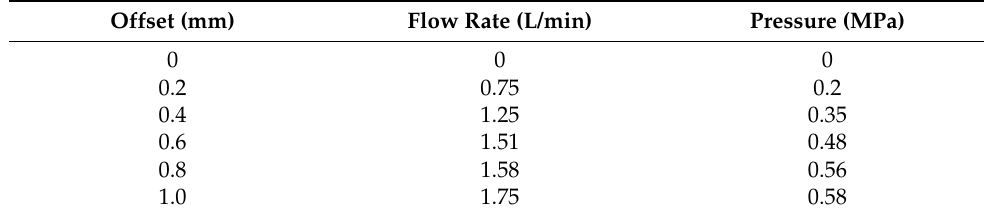
Table 4. Experiment data.